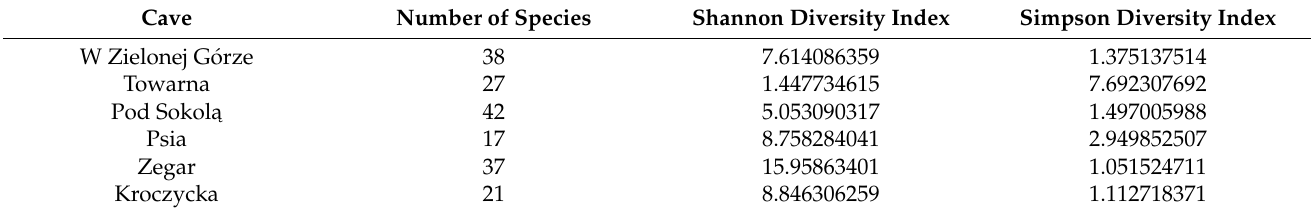
Table 2. Number of species collected in the studied caves and the value of the species richness indices.